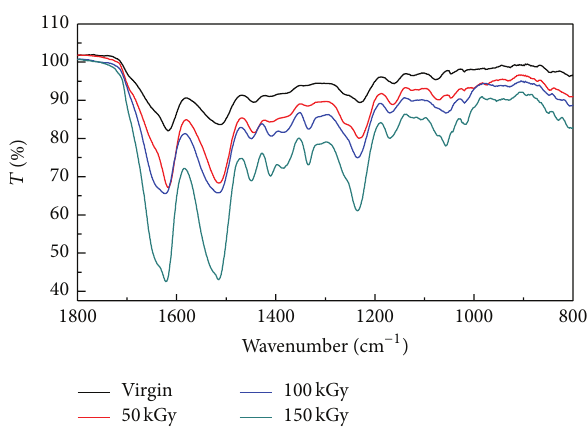
Figure 8: FT-IR spectra of virgin and electron irradiated silk fibroin